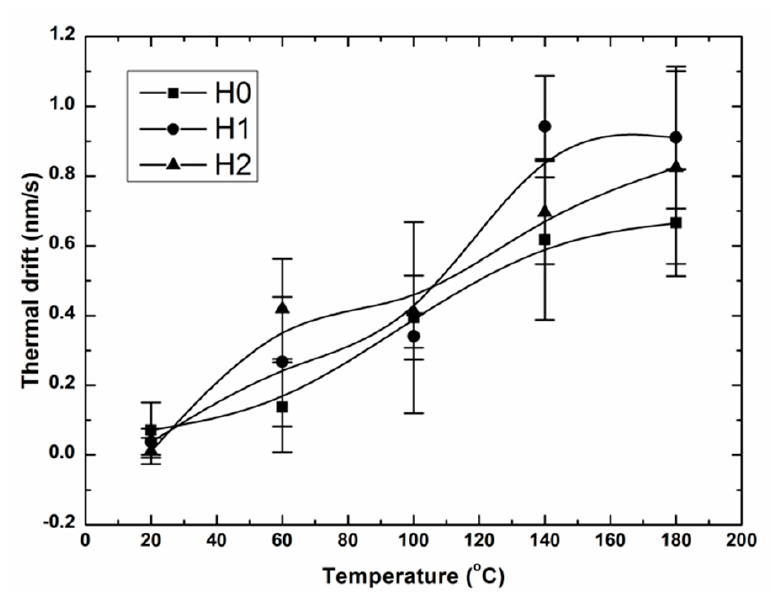
Figure 4. Thermal drift rate with different service temperatures.